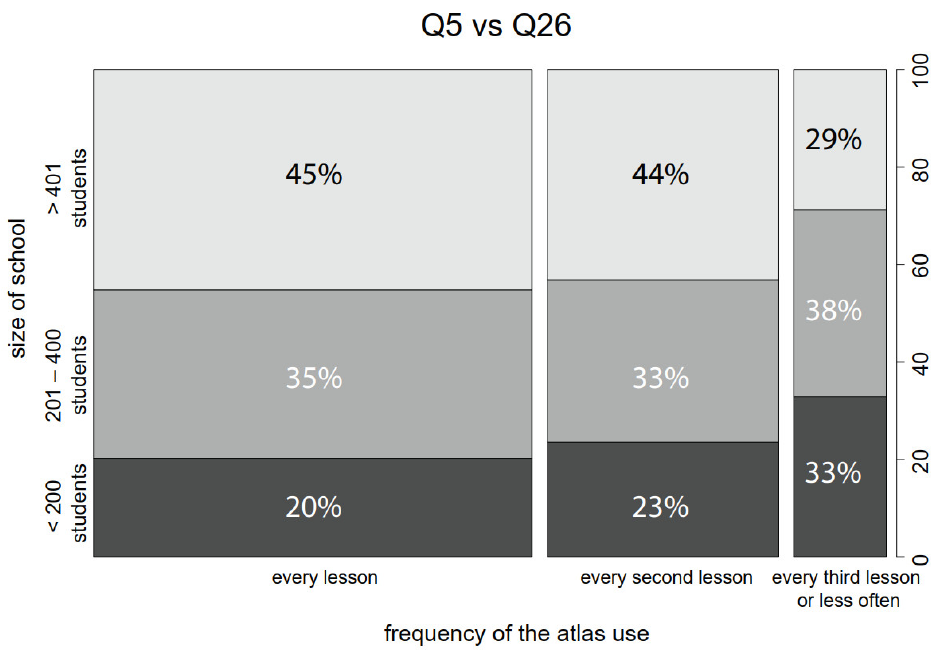
Figure 13. The influence of school size (Q26) on the frequency of atlas use (Q5).